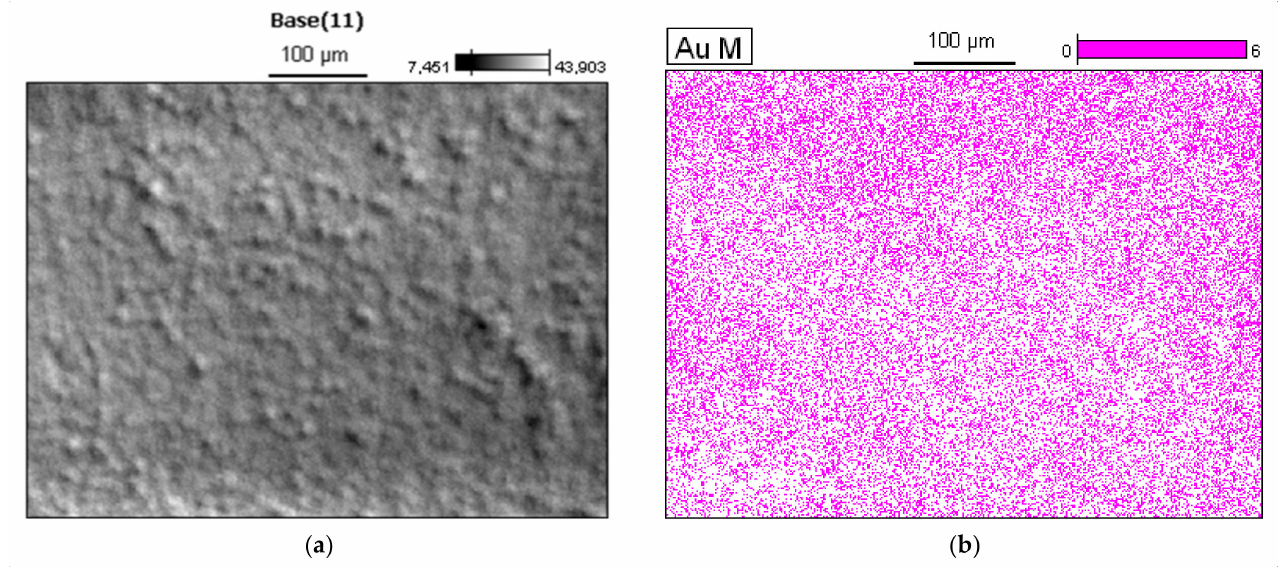
Figure 16. ( a ) SEM/EDS image of the surface of the β -Ga 2 O 3 layer; ( b ) distribution map of Au nanoparticles on the surface of the β -Ga 2 O 3 layer. Determined by the EDS